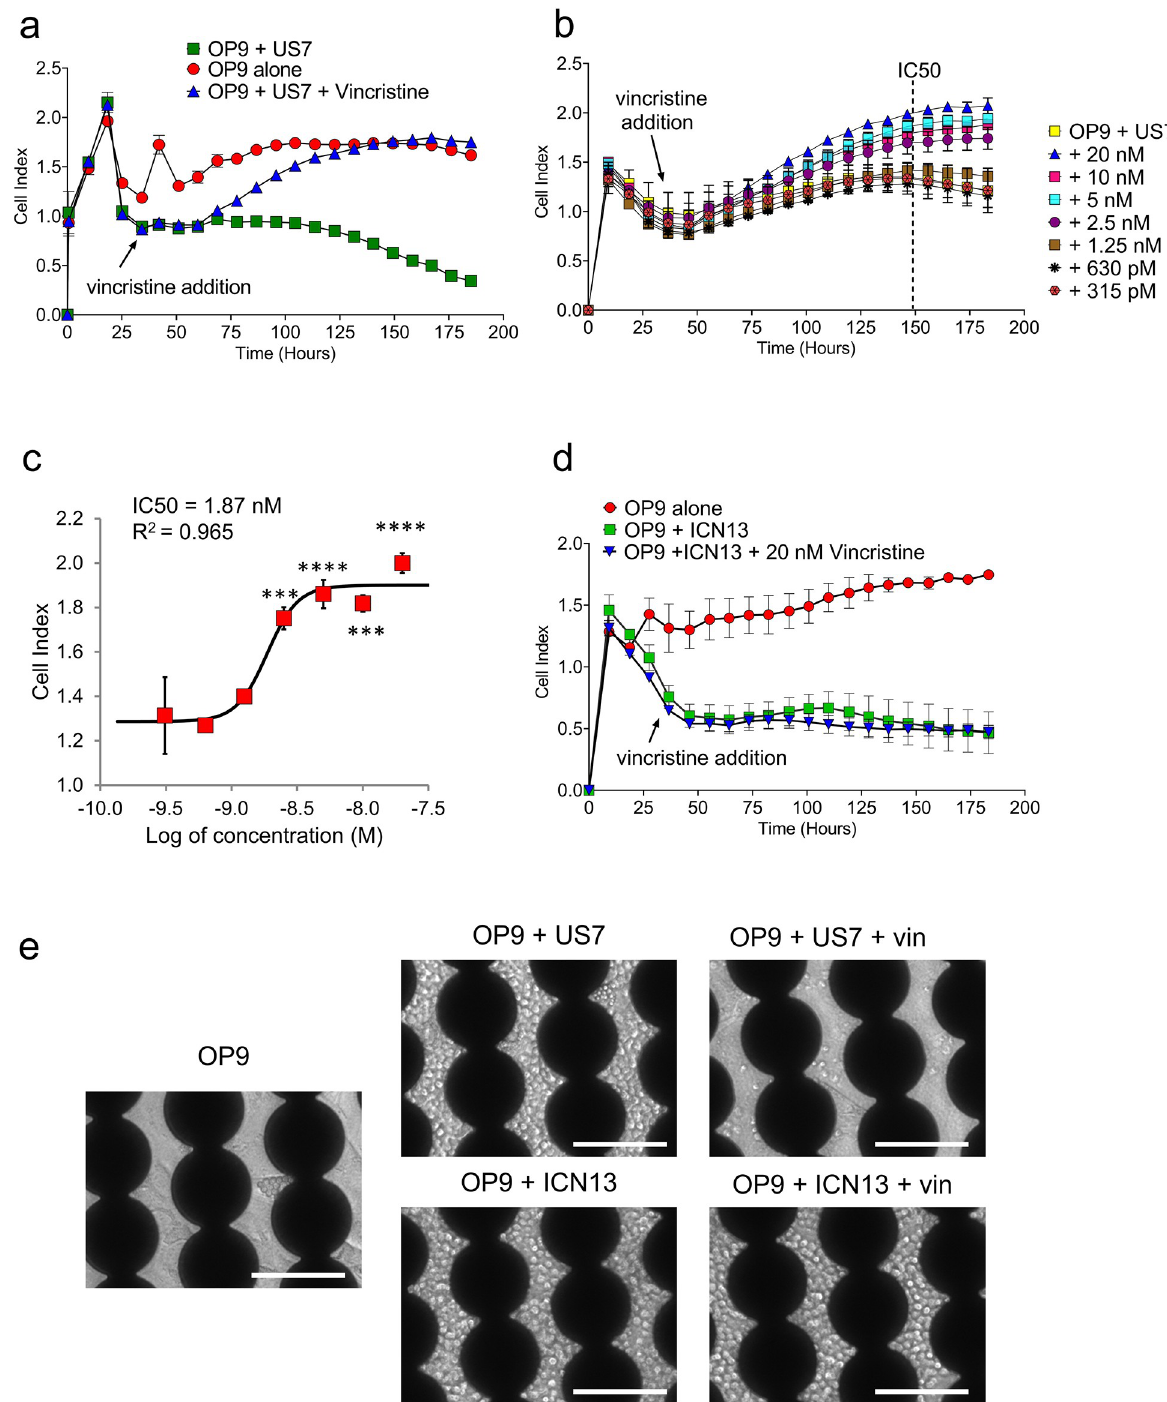
Fig 4. OP9 displacement can be used for monitoring drug cytotoxicity on BCP-ALL cells. (A) US7 cells treated with 100 nM vincristine as indicated (n = 2). (B) Cell Index profile of dose-response to vincristine treatment of OP9+US7. Dotted line indicates the time point used for calculating the IC50 (n = 3 except 1.25nm and 315pm n = 2). (C) Dose-response curve and IC50 calculated from the Cell Index profile in panel B. The IC50 value for vincristine treatment of US7 was 1.87 nM. Statistical analysis was done using one-way ANOVA followed by Dunnett’s multiple comparison test. Error bars represent standard deviation. p values relative to control: ��� < 0.001; ���� < 0.0001 (D) ICN13 cells treated with 20 nM vincristine (n = 2). (E) Images of cells indicated in the figure inside the 16-well plate devices, captured after 7 days of treatment with 10 nM (US7) or 20 nM (ICN13) vincristine. Scale bar = 100 μ